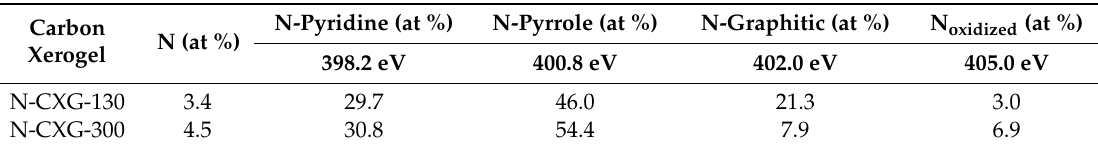
Table 3. Nitrogen content and the different species deconvoluted from the X-ray photoelectron spectroscopy (XPS) N1s